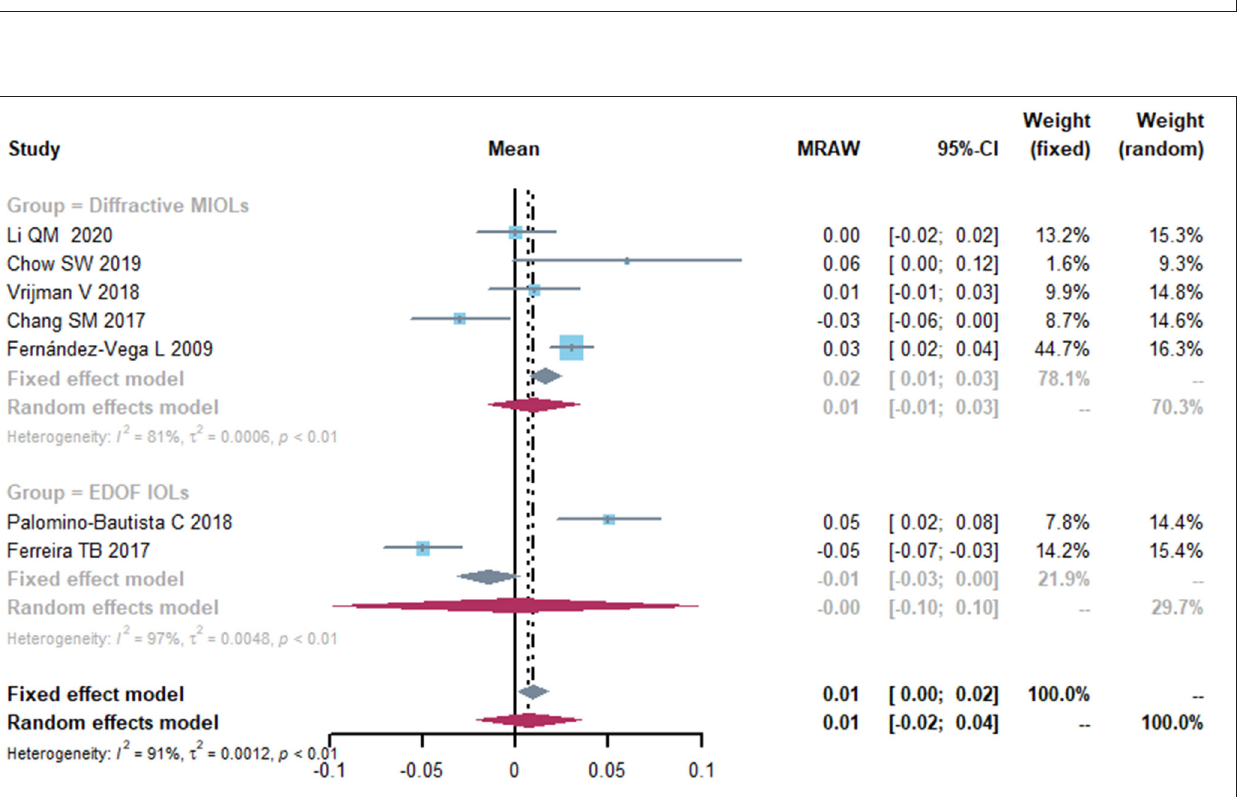
FIGURE 3 | Forest plot of corrected distance visual acuity (CDVA) in logMAR. IOL, intraocular lense; MIOLs, multifocal intraocular lenses; EDOF, extended depth-of-focus; MRAW, the row mean from the study.